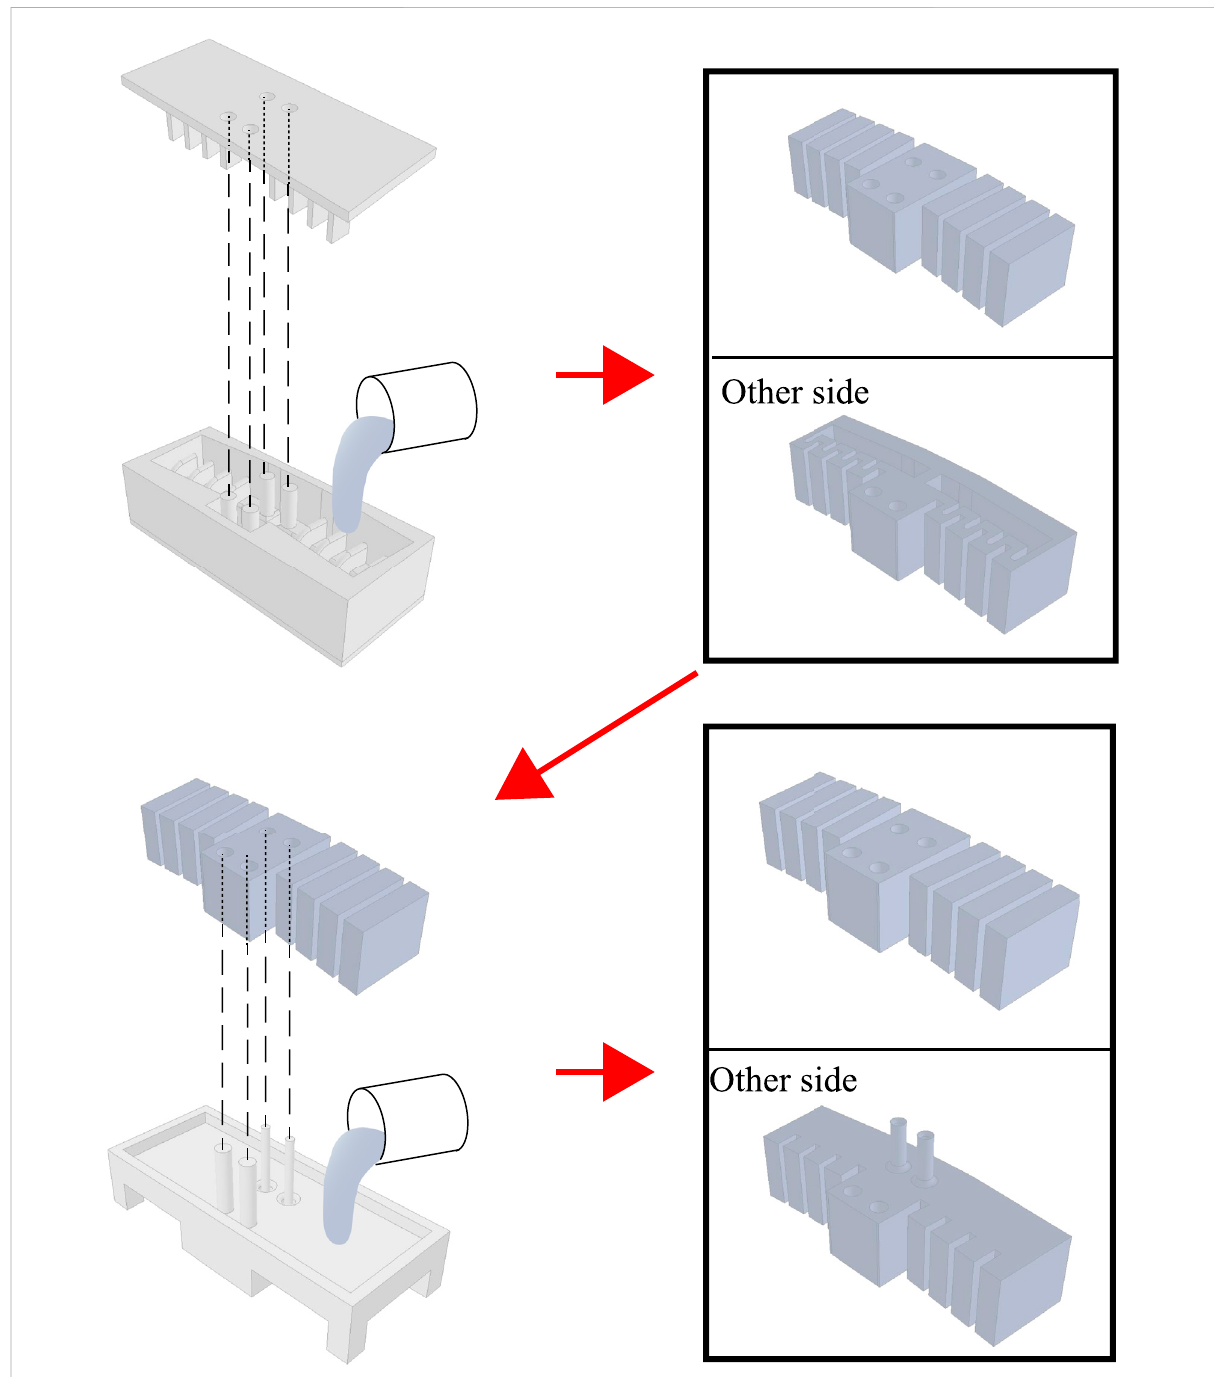
FIGURE 12 Diagram showing the manufacturing procedure. Blue = silicone, gray =